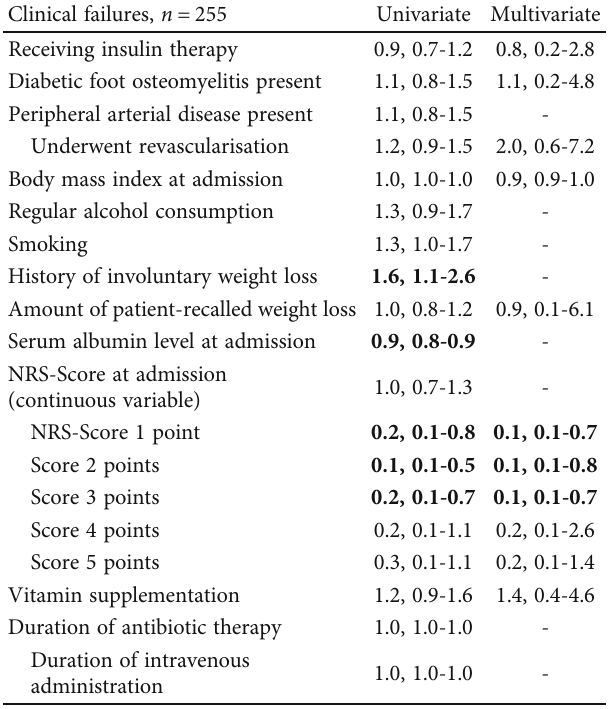
Table 2: Univariate and multivariate associations ( Cox regression analyses with hazard ratios and 95% con fi dence intervals ) targeted to the outcome “ clinical failure ” .